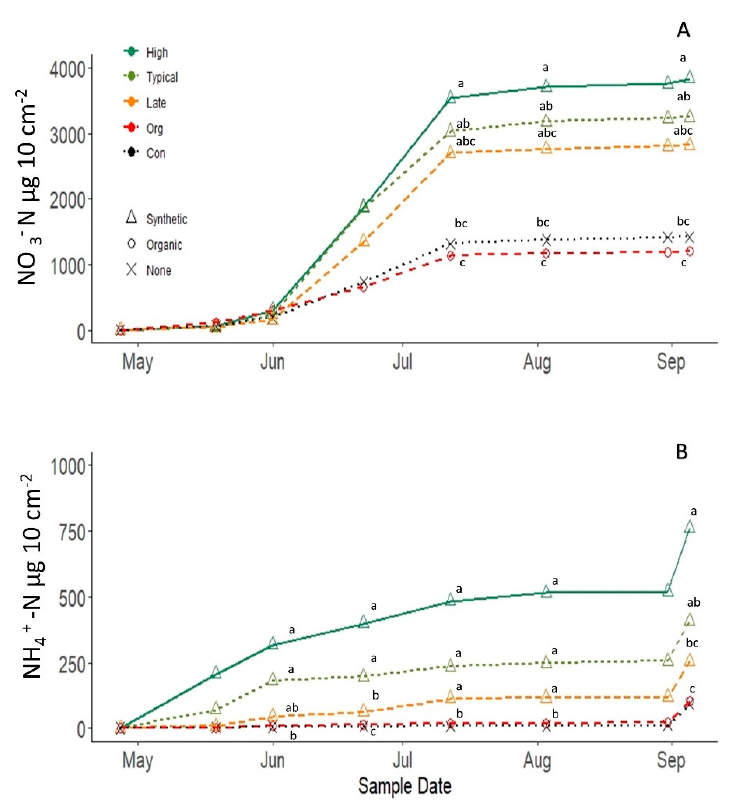
Figure 5. Cumulative nitrogen supply for High fertilizer (High), Typical fertilizer (Typical), Late incorporation (Late), Organic (Org) and Control (Con) treatments. Cumulative nitrate supply (NO 3 − - N) ( A ) and ammonium supply (NH 4+ -N) ( B ) during 2016 growing season. Triangles symbols indicate synthetic fertilizer, open circles are organic fertilizers and X symbol no amendments. Results are means of four replicates and different letters indicate significant differences ( p < 0.05). Note that Y axes scale differs between figure ( A ) and ( B ).